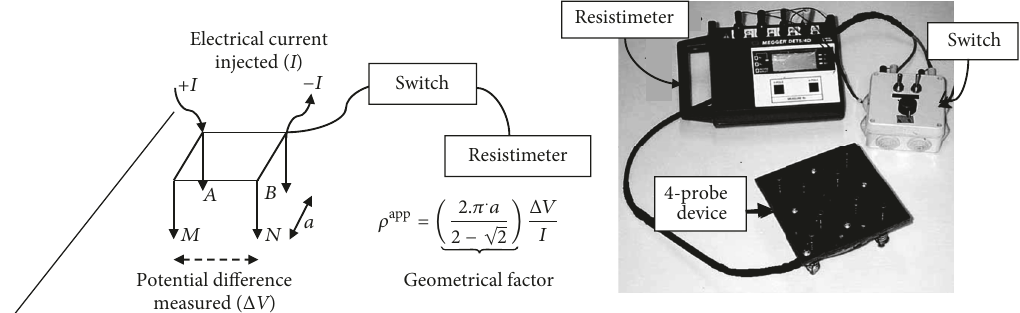
Figure 6: Four-probe square array principle